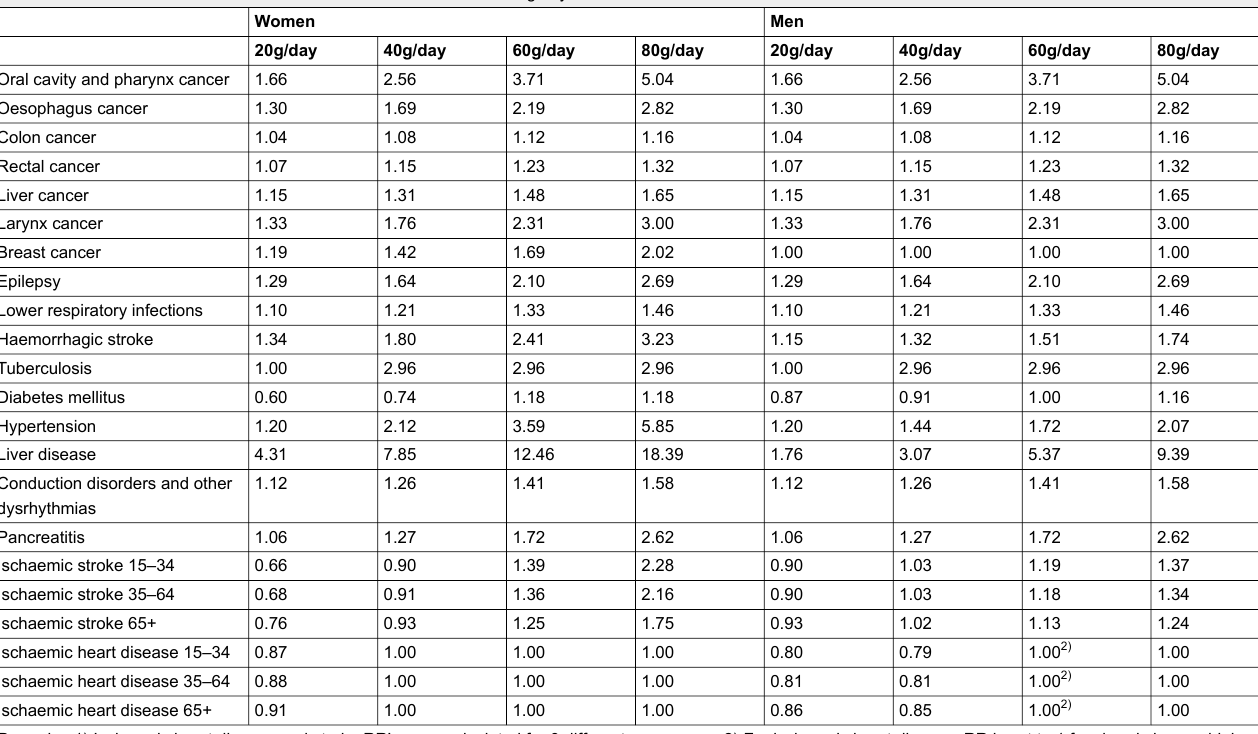
Table 1: Values of the continuous relative risk functions at 20/40/60/80 g/day .